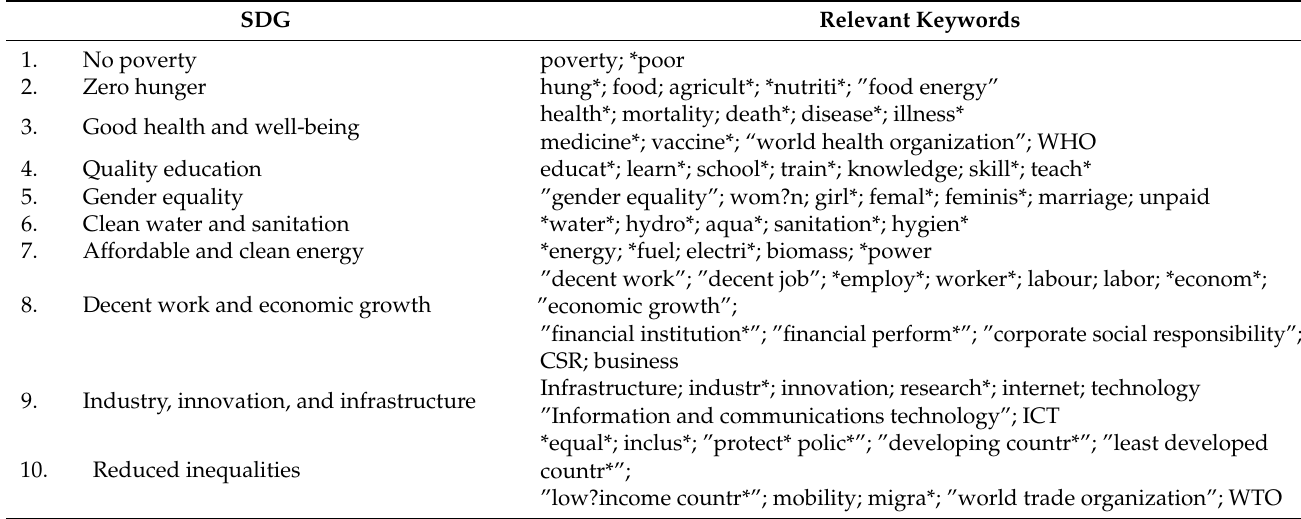
Table 1. Guidelines for categorizing the selected SDG-related review papers.